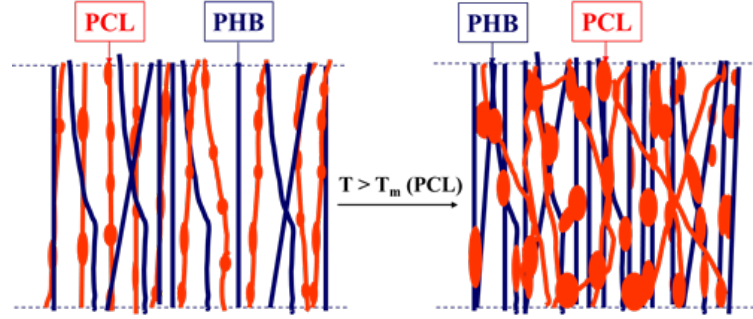
Figure 3. Schematic representation of the working hypothesis.